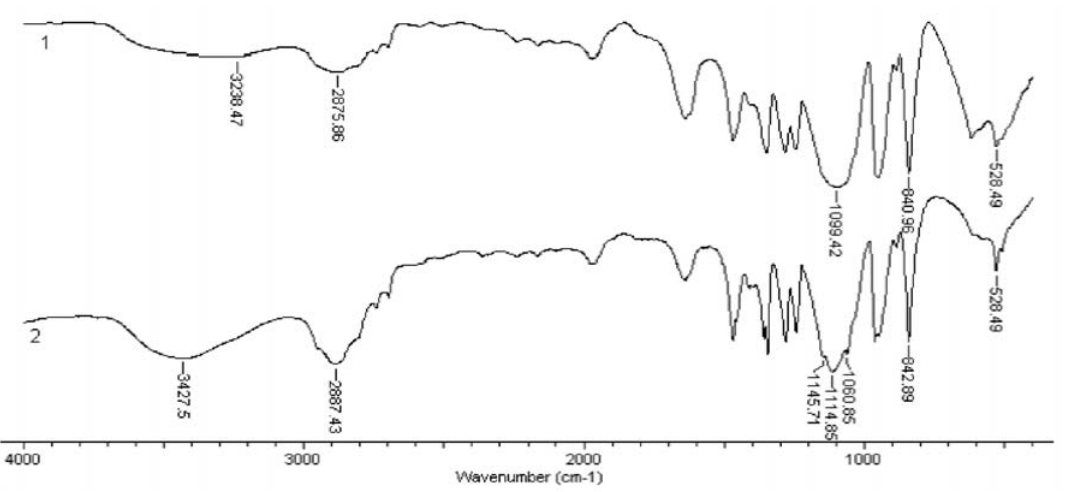
Fig. 4 IR spectra of solid PEG-rich extract without (1) and with Cd(II) plus iodide (2), extractant pH = 3.12. (Cd i = 57.05 µ g/mL, [I − ] add = 0.06 mol/L).